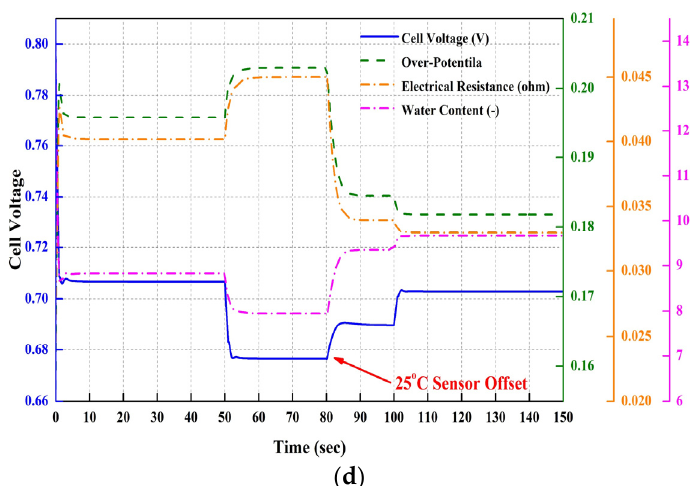
Figure 9. Transient sensor fault behavior in PEM fuel cell under sudden coolant inlet sensor offset (( a ) Temperature of stack and coolant inlet, ( b ) cooling components, ( c ) heat rejection in stack, ( d ) voltage responses).